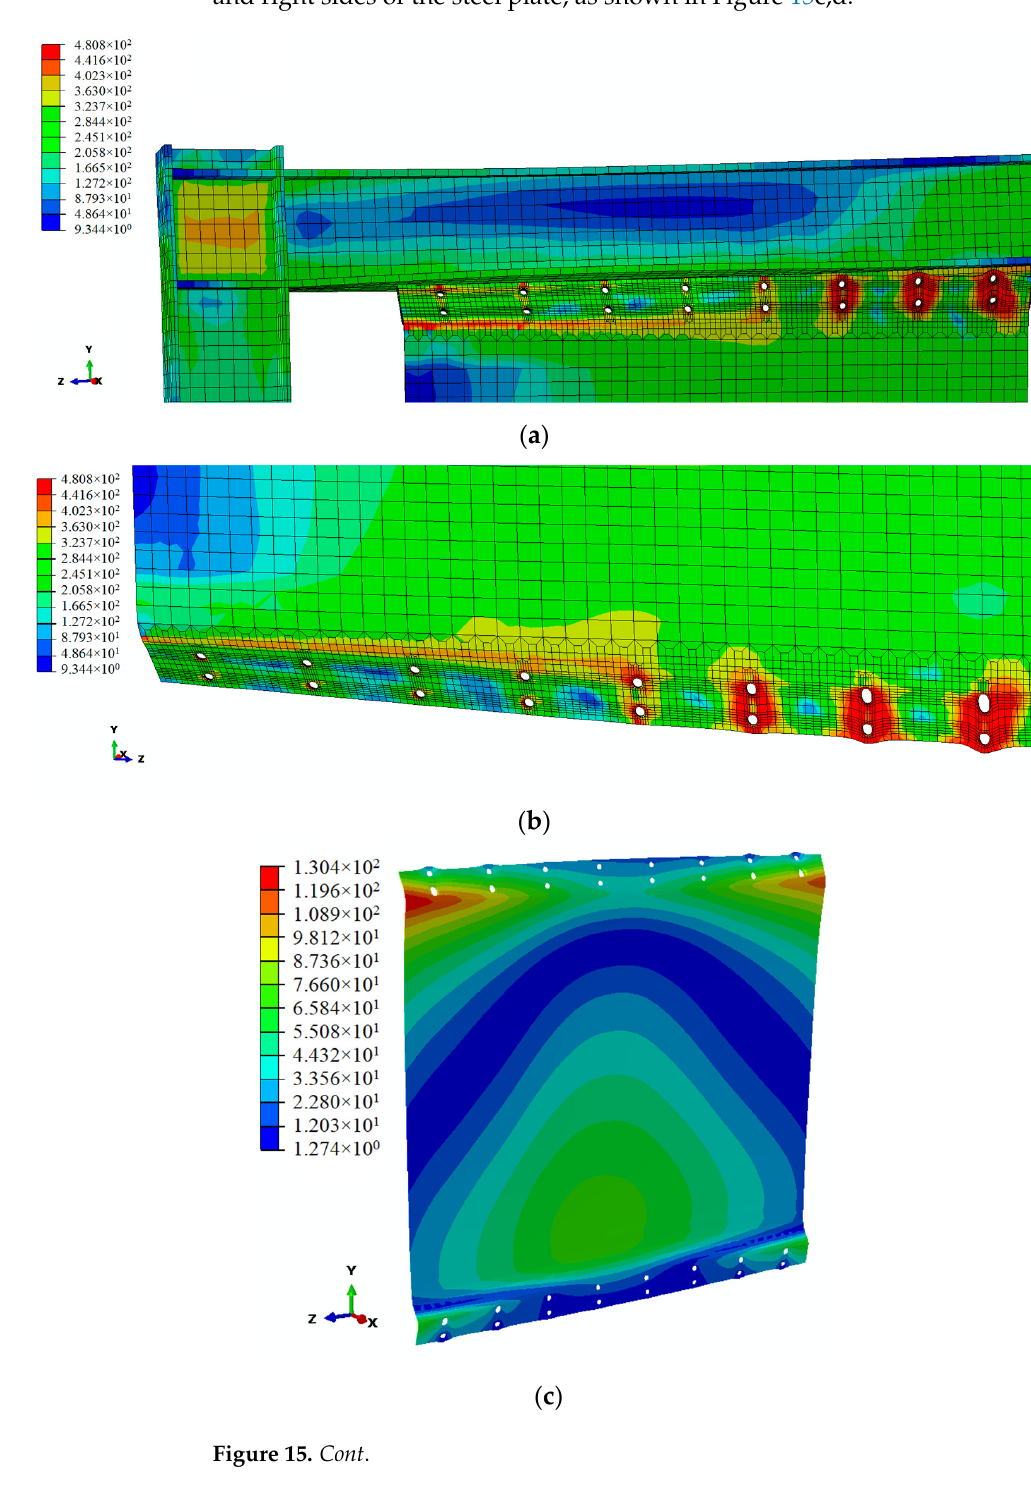
( d ) Figure 15. Stress and deformation cloud diagrams of model SPSW-N8: ( a ) stress cloud of bolt holes at the upper end of steel plate under pull monotonic loading (unit: MPa); ( b ) stress cloud of bolt holes at the lower end of steel plate under pull monotonic loading (unit: MPa); ( c ) deformation cloud of steel plate at the end of cyclic loading (unit: mm); ( d ) left-view cloud of deformed and unde- formed steel plate at the end of cyclic loading (unit: mm). The out-of-plane deformation cloud diagrams of the two bolt-connected SPSW mod- els (SPSW-N8 and SPSW-N8-X), SPSW-T and SPSW-T-X at a drift ratio of 0.02 under cyclic loading are displayed in Figure 16. The out-of-plane deformations of the left edge, right edge and middle region of the steel plate of each SPSW model at a drift ratio of 0.02 under cyclic loading were determined and are displayed in Figure 17. As can be observed, for the bolt-connected SPSW models, the largest out-of-plane deformation easily appeared at the region of the steel plate aligned with the length edge of the connectors under cyclic loading. In other words, measures must be taken for SPSWs with two-sided connections with bolts and fl at steels (such as adding sti ff ening ribs, adding connectors, increasing bolt